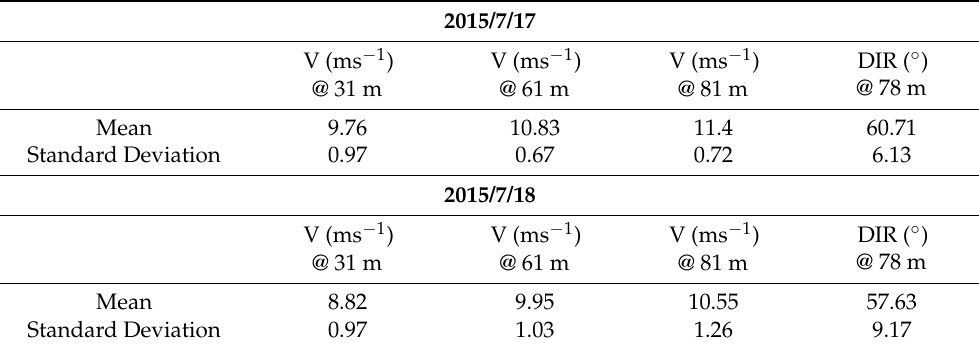
Table 1. Mean and standard deviation values of wind speed (V) and wind directions